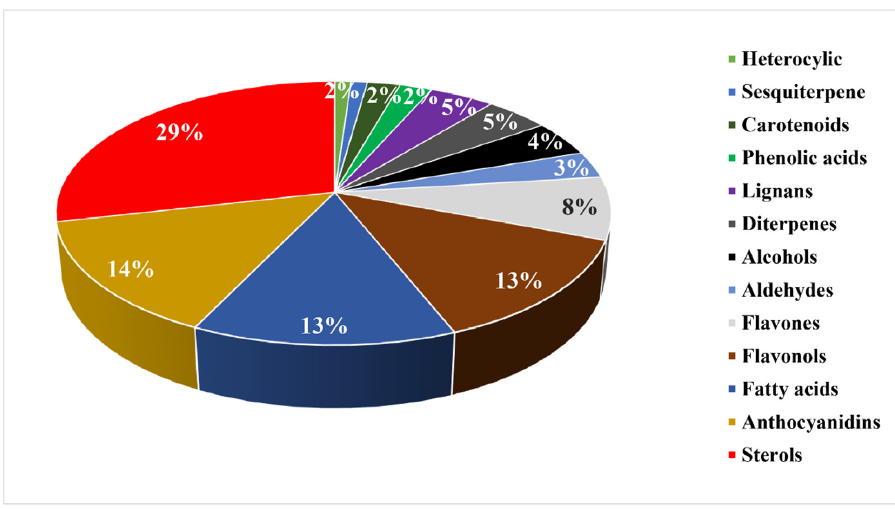
Figure 5. Chemical compounds isolated from Blechnum species.